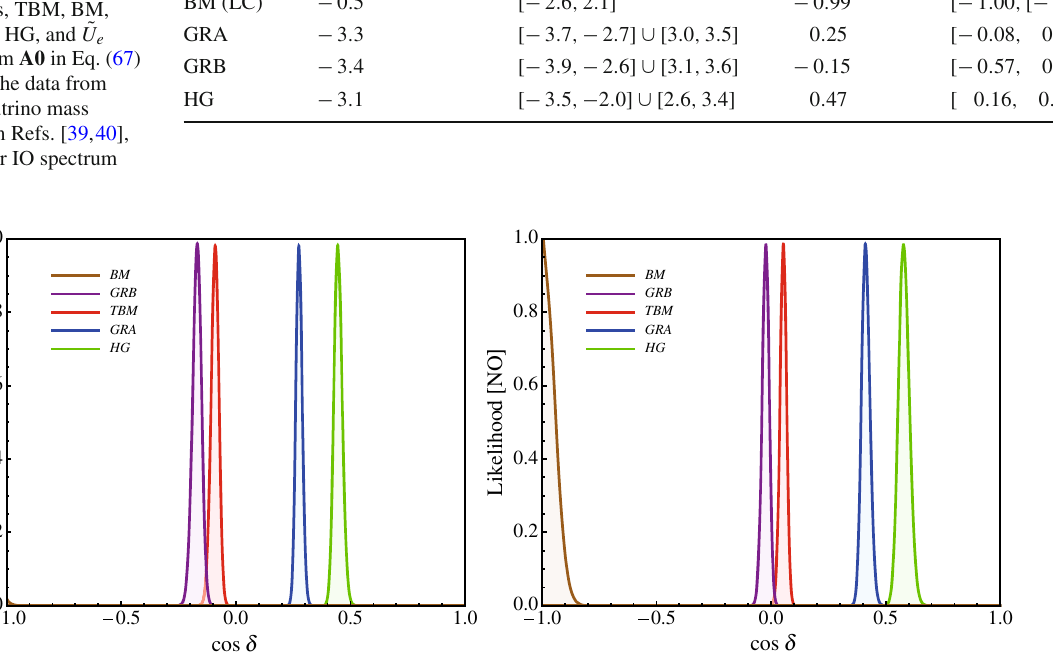
Fig. 2 The likelihood function versus cos δ for NO neutrino mass spectrum after marginalising over sin 2 θ 13 and sin 2 θ 23 , for the TBM, BM (LC), GRA, GRB and HG symmetry forms of the mixing matrix U ◦ ν . The figure is obtained by using the prospective 1 σ uncertainties in the determination of sin 2 θ 12 , sin 2 θ 13 and sin 2 θ 23 within the Gaus-